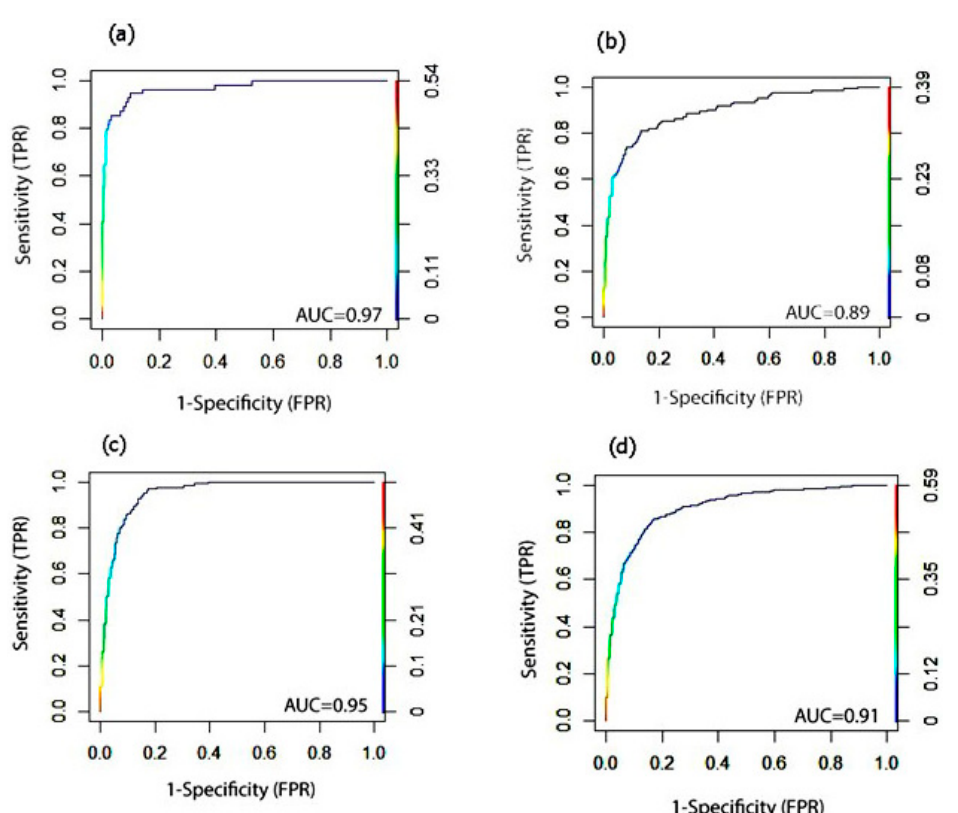
Figure 5. Receiver operating characteristic (ROC) curves depicting validity and performance of binomial logistic regression analyses results for urban expansion in Wa Municipality for the following years: ( a ) 1990, ( b ) 2001, ( c ) 2010 and ( d ) 2020. (FPR: false positive rates; TPR: true positive rates; AUC: area under the curve).